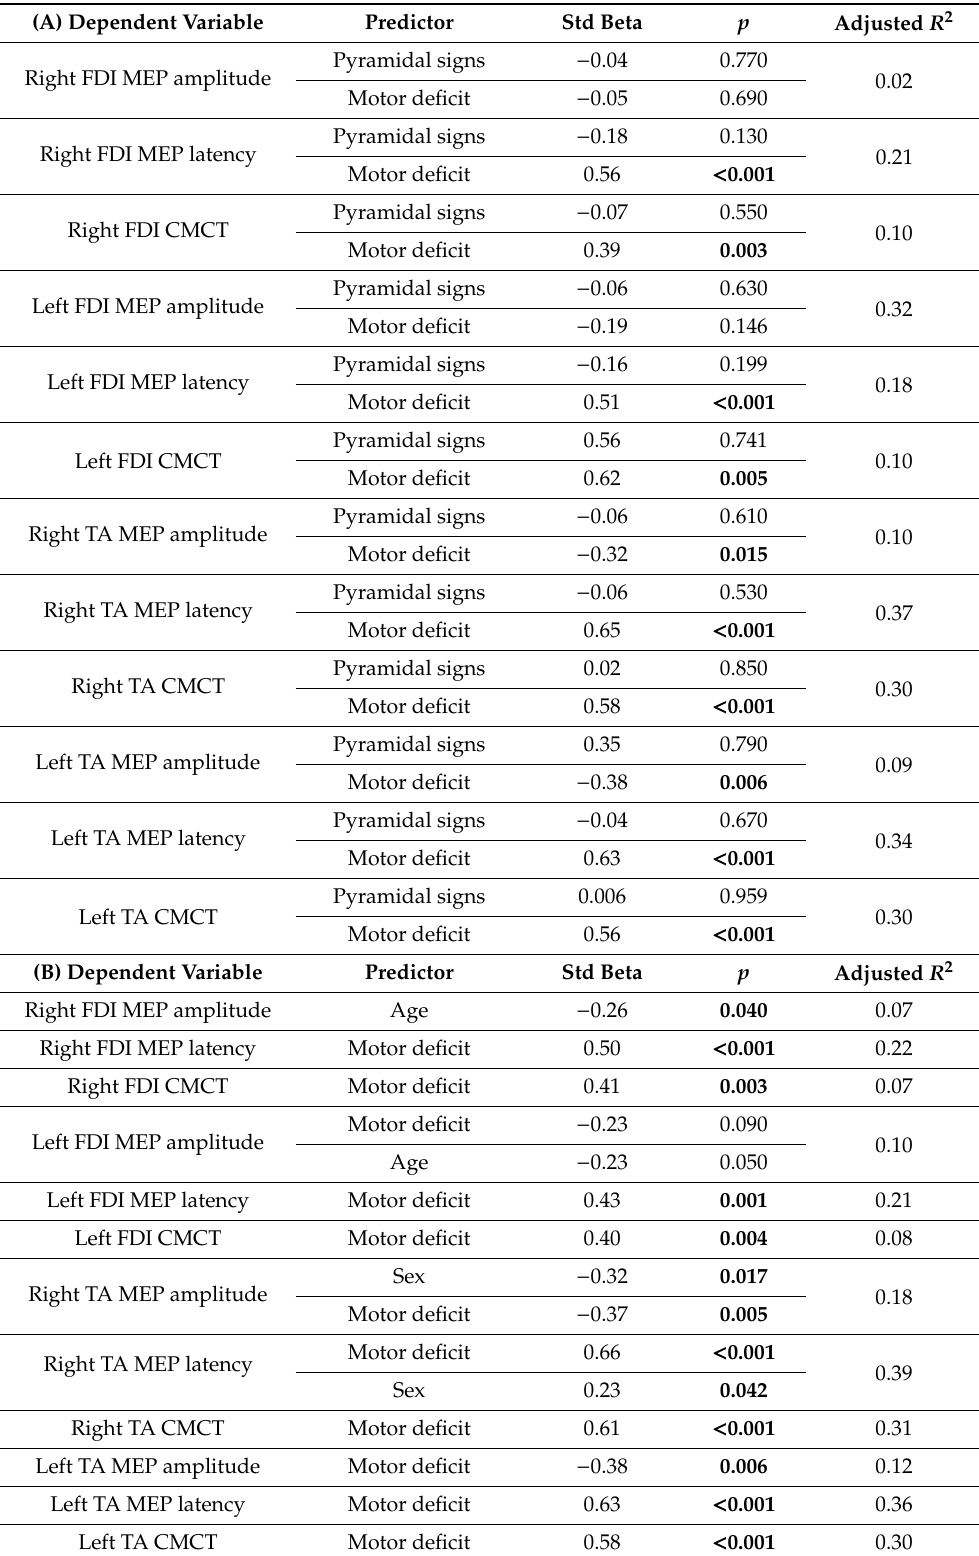
Legend: FDI = first dorsal interosseous muscle; TA = tibialis anterior muscle; MEP = motor-evoked potential; CMCT = central motor conduction time; numbers in bold = statistically significant p